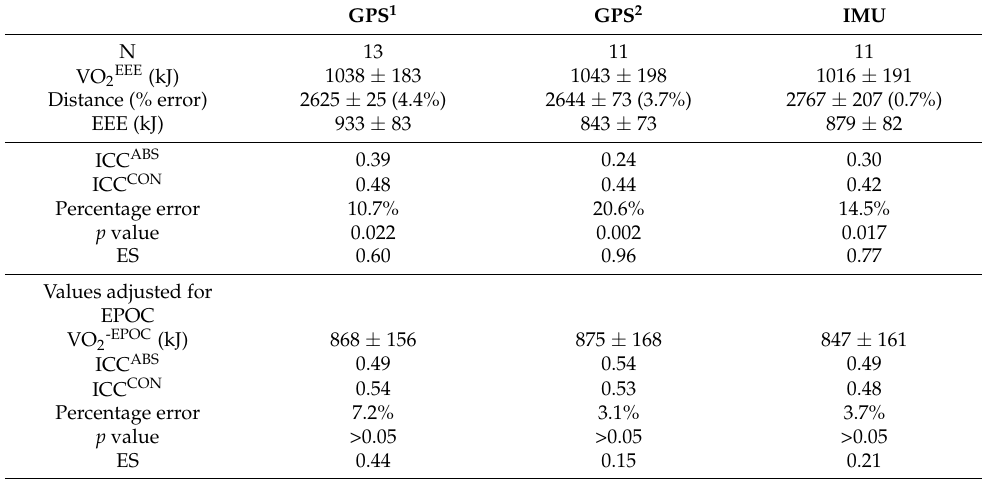
Table 1. Upper panel displays descriptive data for the criterion measure EEE VO2 , distance measured by devices, and total EEE for the individual tracking devices. Middle panel display ICC measures for absolute and consistency measures, percentage error (EEE), as well as paired sample t -test between specific devices and criterion measure for total energy expenditure. Lower panel of the table display the values adjusted, by removing EPOC measurement from the criterion measure value (VO 2 ), only analyzing moving time. Exercise energy expenditure = EEE; kilojoule = kJ; effect size = ES; post-exercise energy consumption =